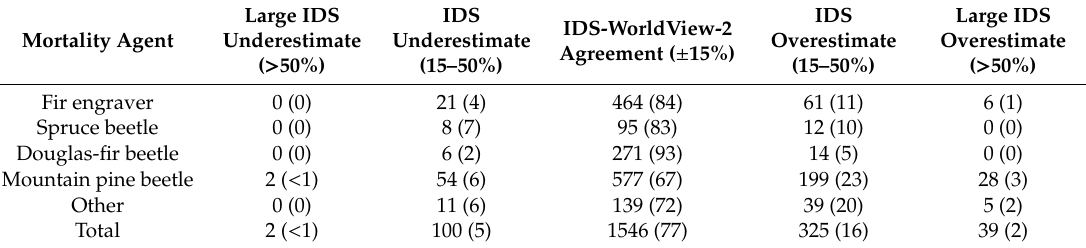
Table 7. Severity estimation accuracy of IDS polygons by mortality agent using the FHAAST method. Percentages are given in parentheses next to polygon counts. N = 2012 polygons total. Overall accuracy =